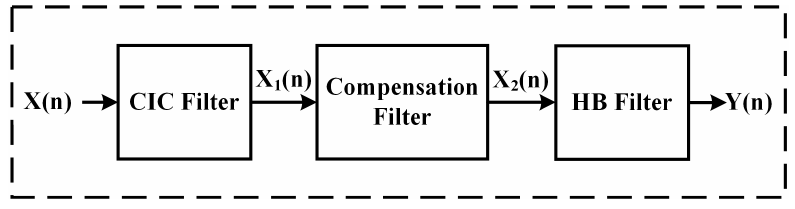
Figure 3. Block diagram of the digital decimation filter.